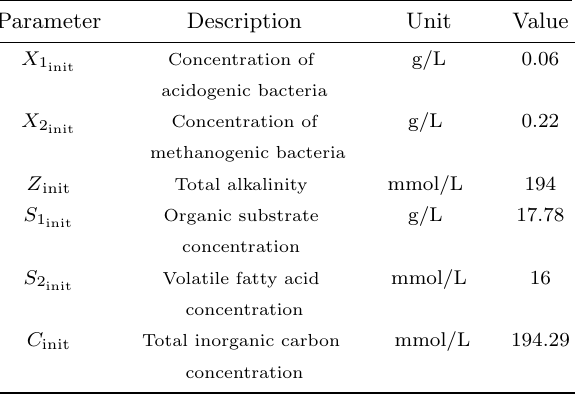
Table 2: The initial state in the AM2 model